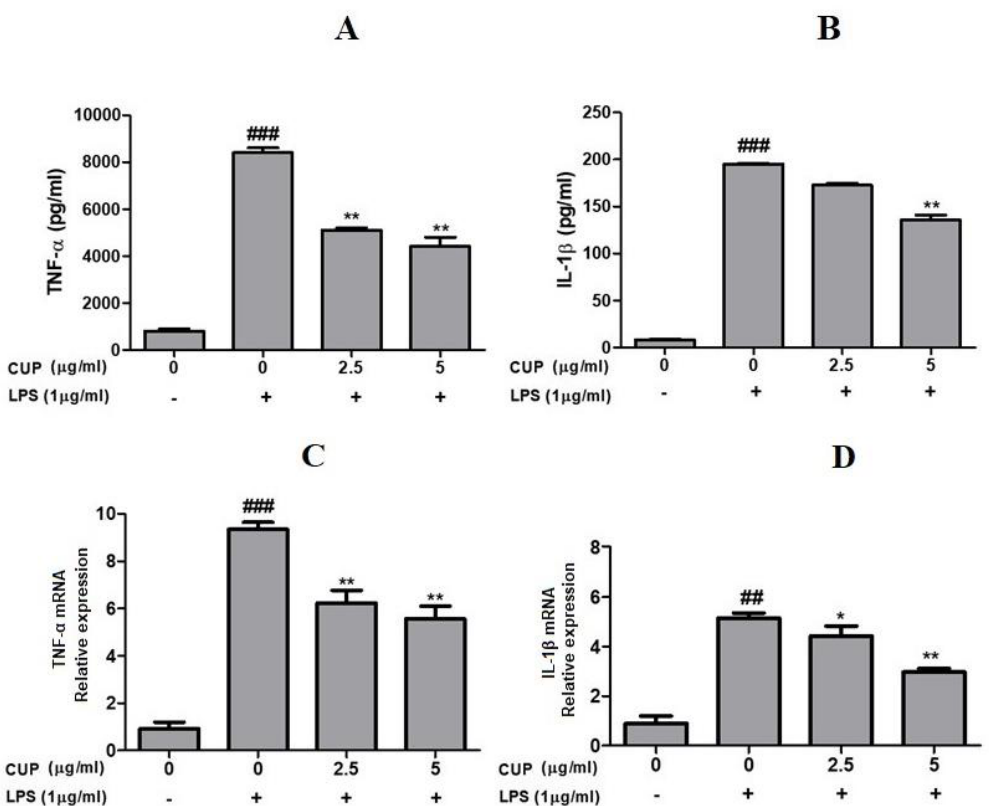
Figure 5. Effect of Citrus unshiu peel (CUP) flavonoids on TNF- α and IL-1 β levels in LPS-stimulated RAW264.7 cells. TNF- α and IL-1 β levels measured in cells treated at different concentrations of CUP flavonoids (0, 2.5, and 5 µ g/mL) for 24 h, with or without 1 h pre-incubation of lipopolysaccharide (LPS) (1 µ g/mL). ( A ) TNF- α and ( B ) IL-1 β levels by ELISA assay. ( C ) TNF- α and ( D ) IL-1 β mRNA relative expression by qRT-PCR analysis. Note: Data are the mean ± SEM of experiments in triplicate (n = 3). ## p < 0.01 vs. un treated group; ### p < 0.001 vs. untreated group; * p < 0.05 and ** p < 0.01 vs. LPS-alone treated group. Relative expression of TNF- α and IL-1 β was measured and β -actin was used as internal